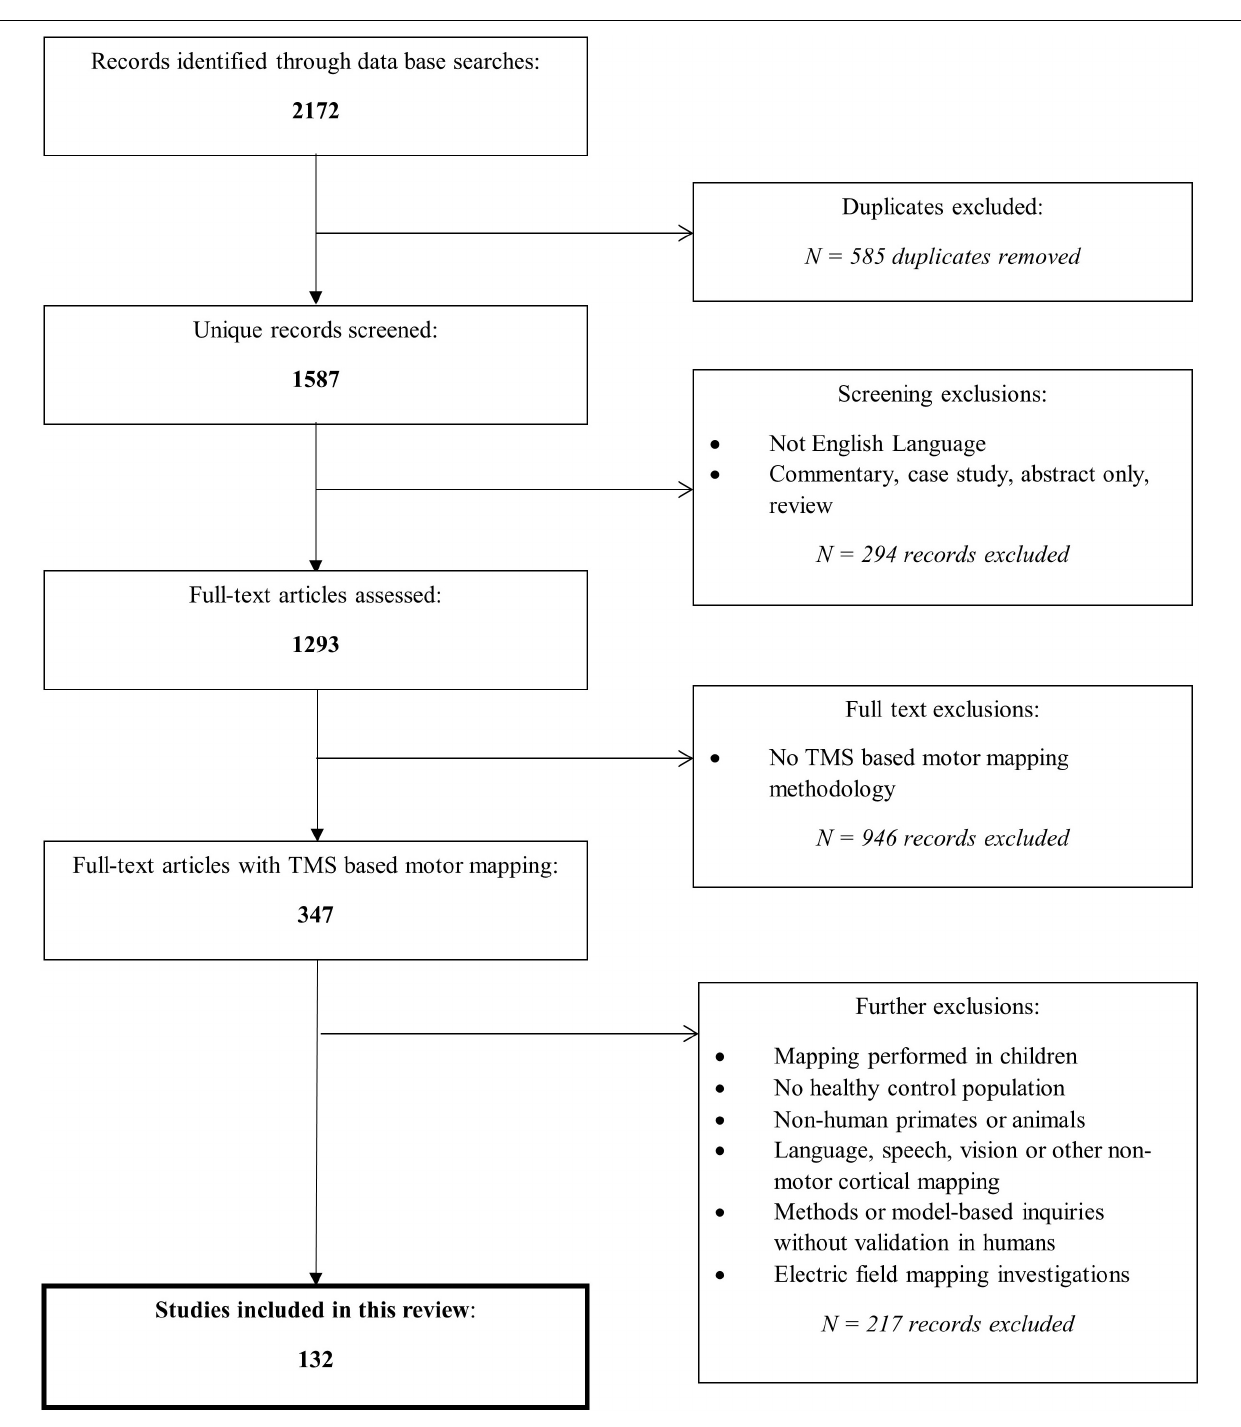
Frontiers in Neuroscience |